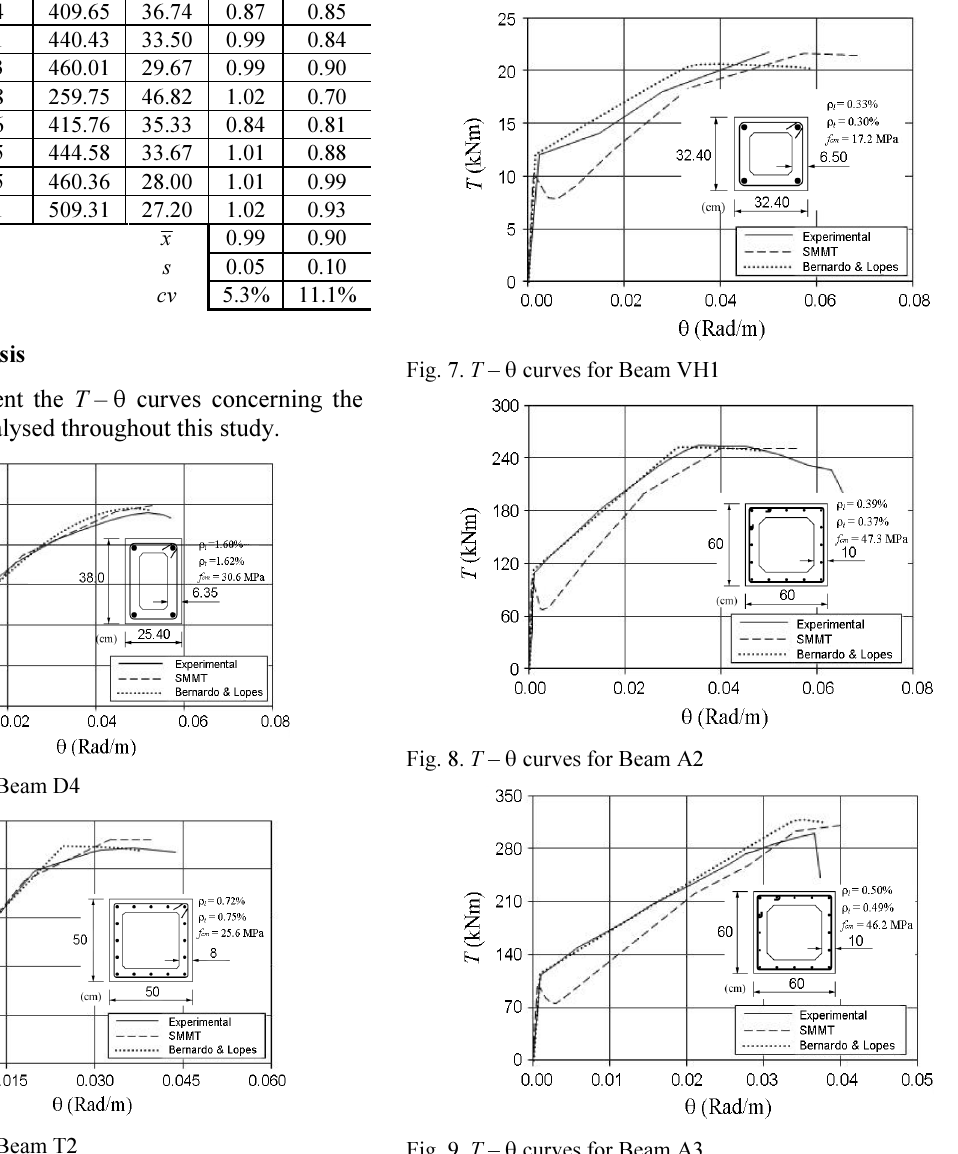
Fig. 6. T – θ curves for Beam T1